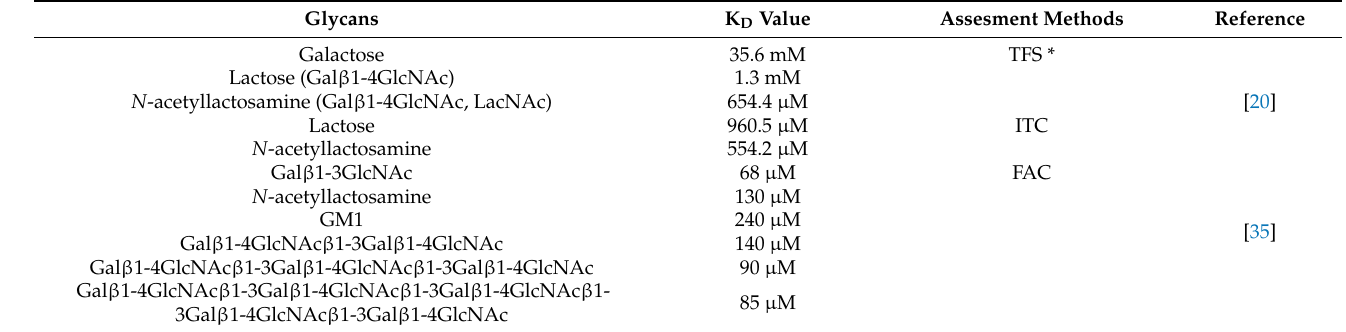
Table 1. Binding of galectin-2 to galactose-terminated glycans. * TFS, Tryptophan Fluorescence Spectroscopy; ITC, Isothermal Titration Calorimetry; FAC, Frontal Affinity